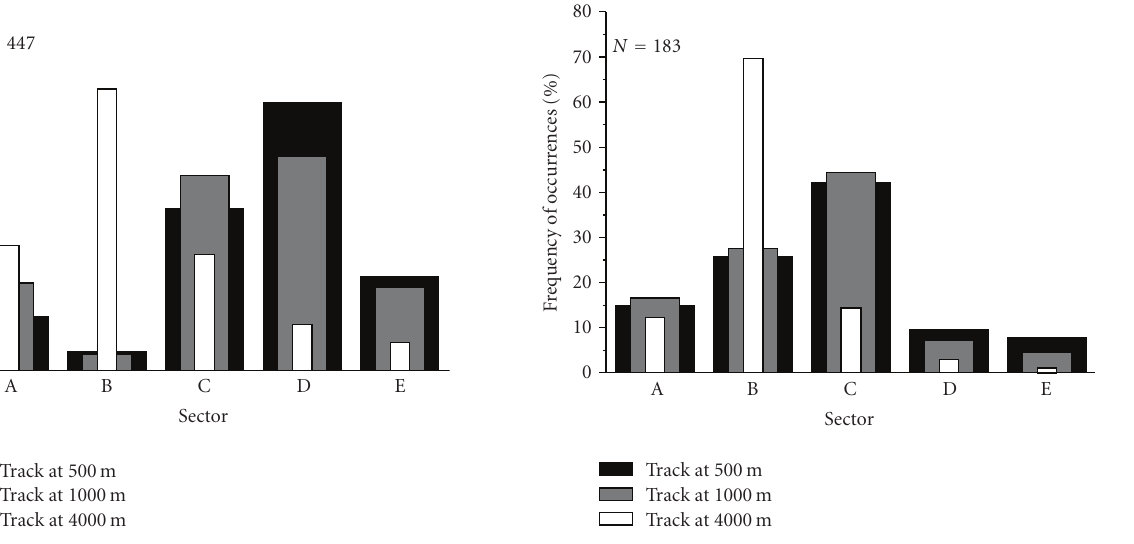
Figure 3: Frequency (%) distribution of the air-mass trajectories at three atmospheric levels over GAA for the UI aerosol type. The number of data, N, is also given.